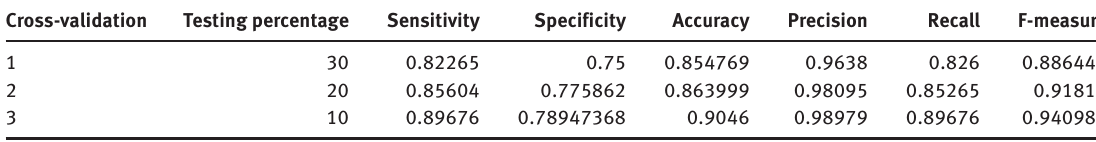
Table 2: Performance Analysis by the Cross-Validation Method. Cross-validation